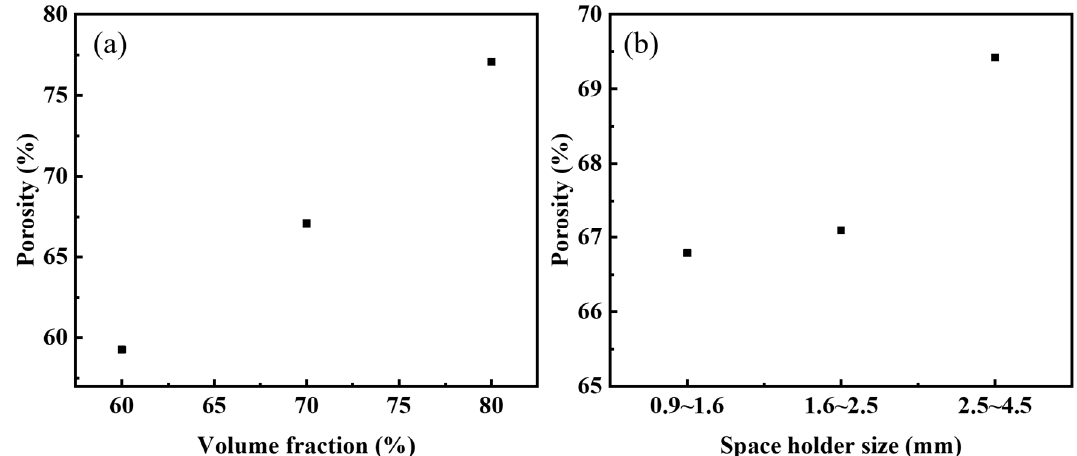
Figure 3. Actual porosity versus ( a ) volume fraction of urea and ( b ) size of urea. Table 1. Statistics of pore structure parameters.